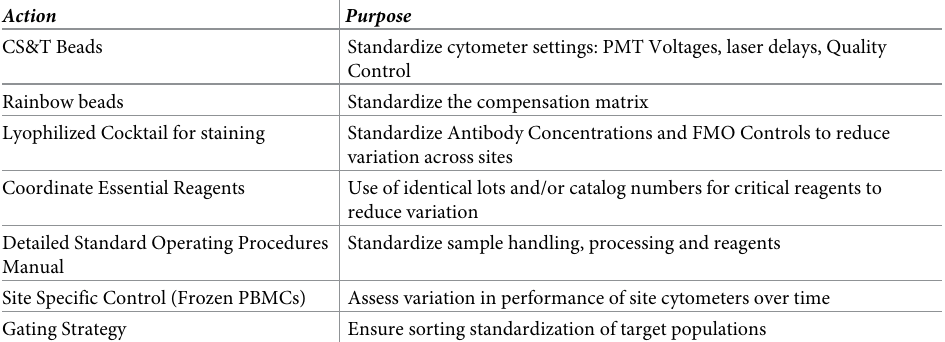
Table 1. Standardization actions taken and purpose for the identification and collection of cell populations in flow